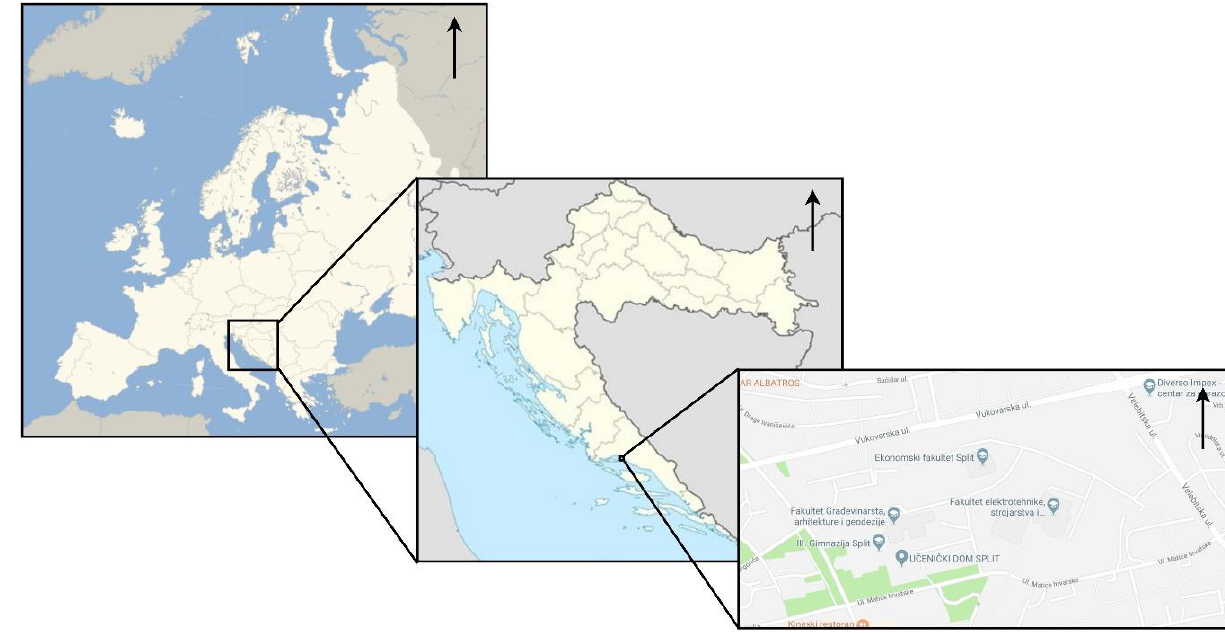
Figure 3. Campus, University of Split.